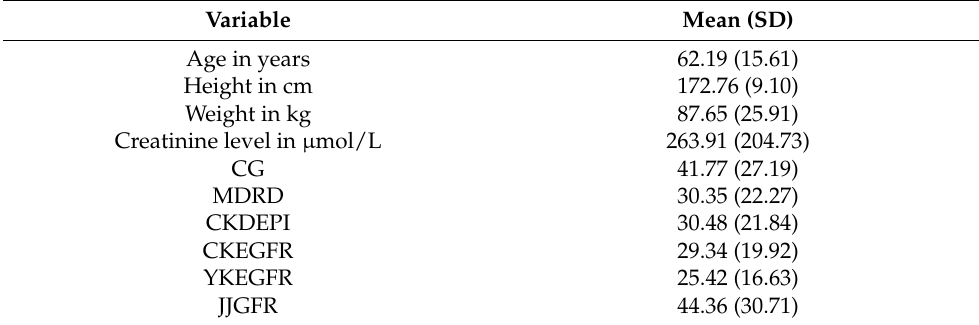
Table 1. The baseline demographics of patients (the Cockcroft–Gault (CG) estimator, the modification of diet in renal disease (MDRD) estimator, the chronic kidney disease epidemiology collaboration (CKD-EPI) equation, the kinetic glomerular filtration rate (GFR) estimator by Chen (CKEGFR), estimation of creatinine clearance before steady state according to Yashiro (YKEGFR), the Jelliffe and Jelliffe estimator (JJGFR)).